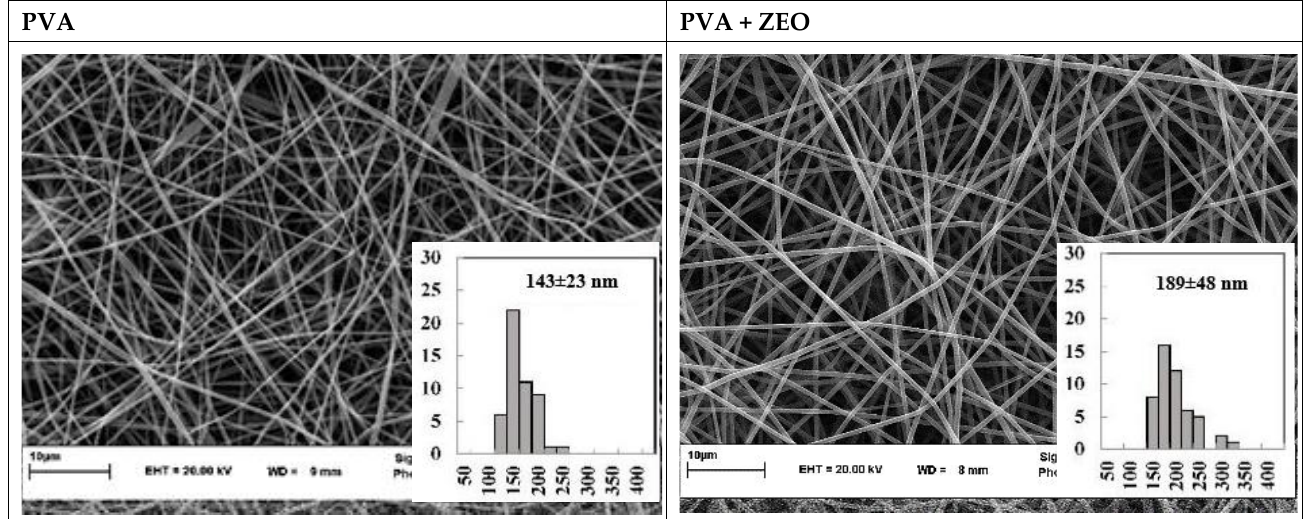
Figure 1. SEM image of PVA and PVA/ZMEO nanofibers, (mean ± SD).